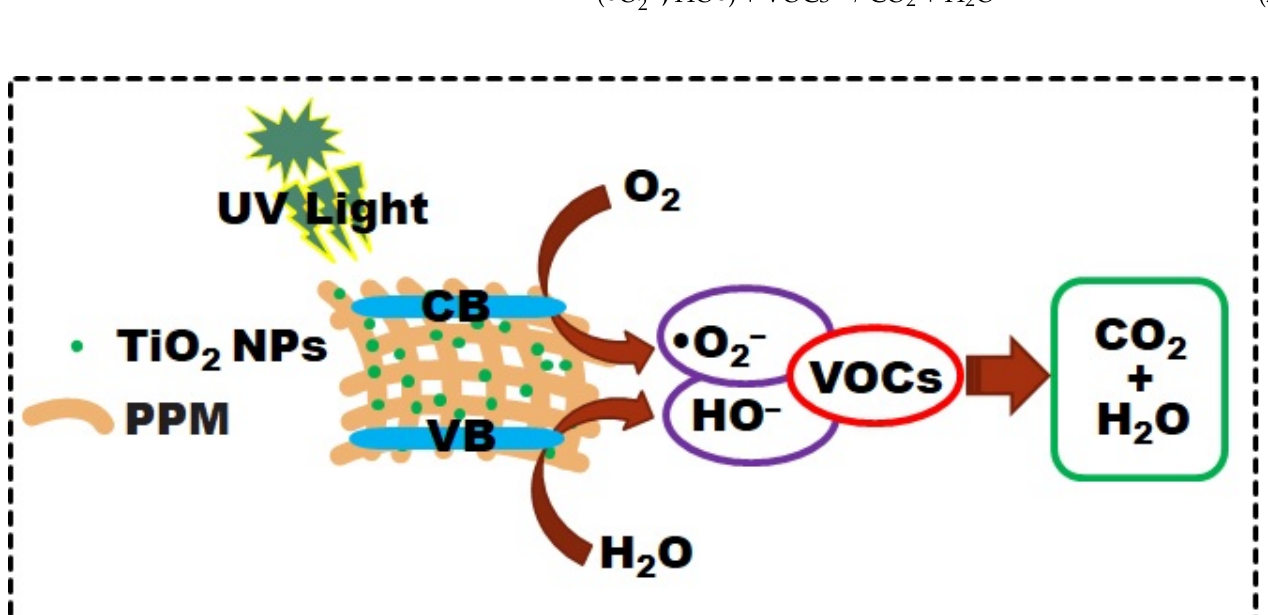
Figure 11. Schematic for the photocatalytic VOC degradation